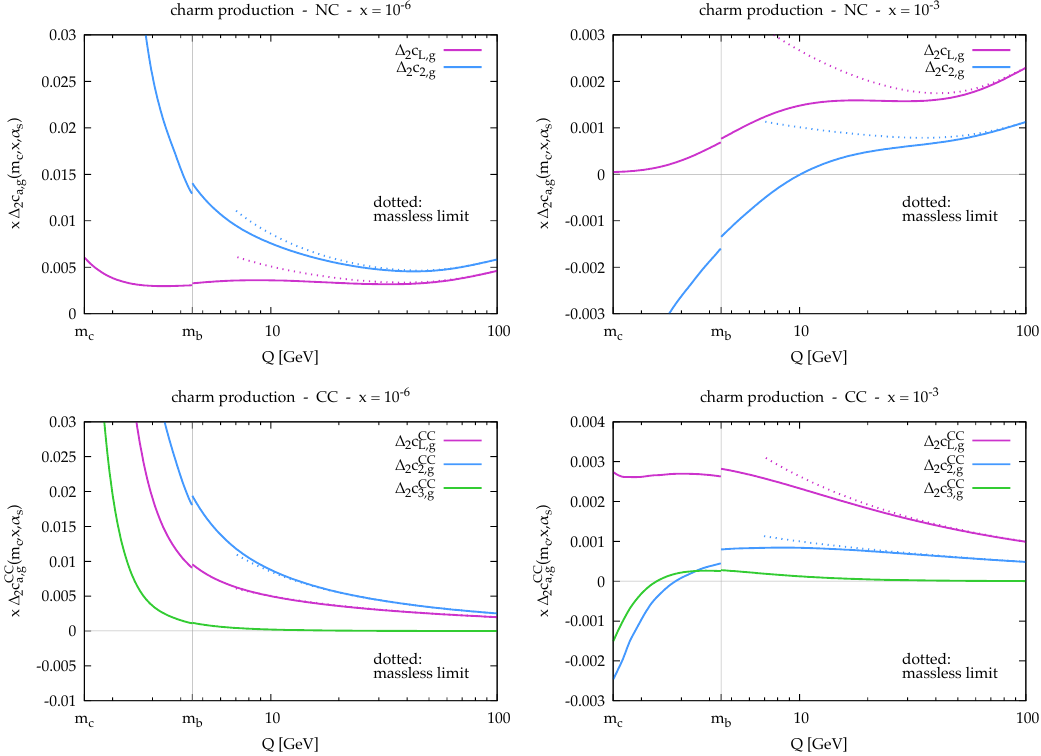
Figure 5 . Resummed contributions to the coe(cid:14)cient functions including mass e(cid:11)ects in neutral current, (cid:1) 2 c L;g ( m c ) and (cid:1) 2 c 2 ;g ( m c ) (upper plots), and in charged current, (cid:1) 2 c CC and (cid:1) 2 c CC ( m c ) (lower plots), shown as a function of Q from m c to 100 GeV. The left plots show 3 ;g the results for x = 10 (cid:0) 6 , the right plots for x = 10 (cid:0) 3 . The value of n f changes from 4 to 5 at the bottom matching scale taken to be equal to m b . The massless result, to which the massive coe(cid:14)cients tend at large Q , is also shown as dotted curves (except for (cid:1) 2 c CC to